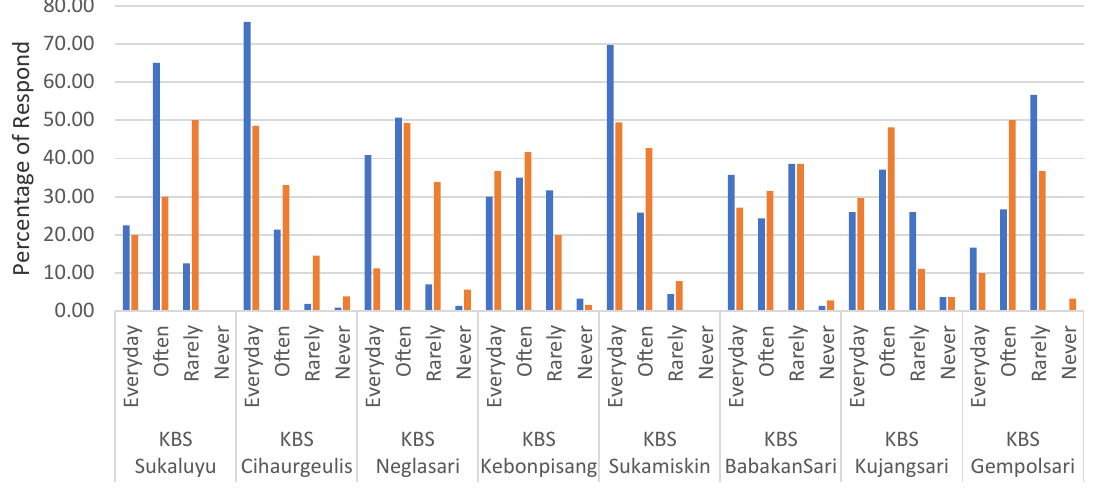
Fig. 6: Waste separation habits of residents in KBS area